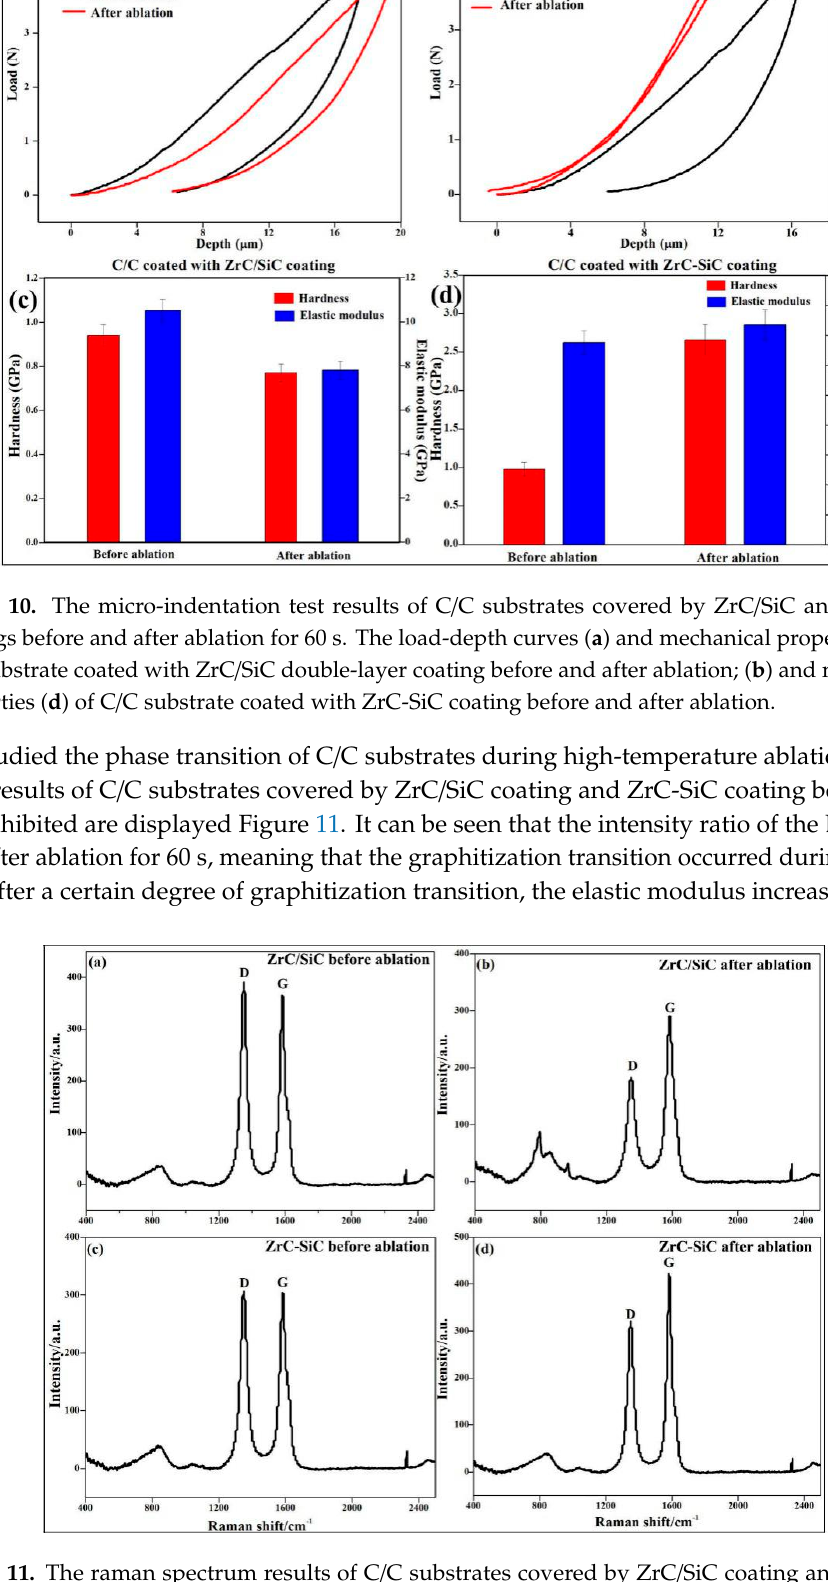
Figure 11. The raman spectrum results of C / C substrates covered by ZrC / SiC coating and ZrC-SiC coating before and after ablation. ( a ) C / C coated with ZrC / SiC coating; ( b ) C / C coated with ablated ZrC / SiC coating; ( c ) C / C coated with ZrC-SiC coating; ( d ) C / C coated with ablated ZrC-SiC